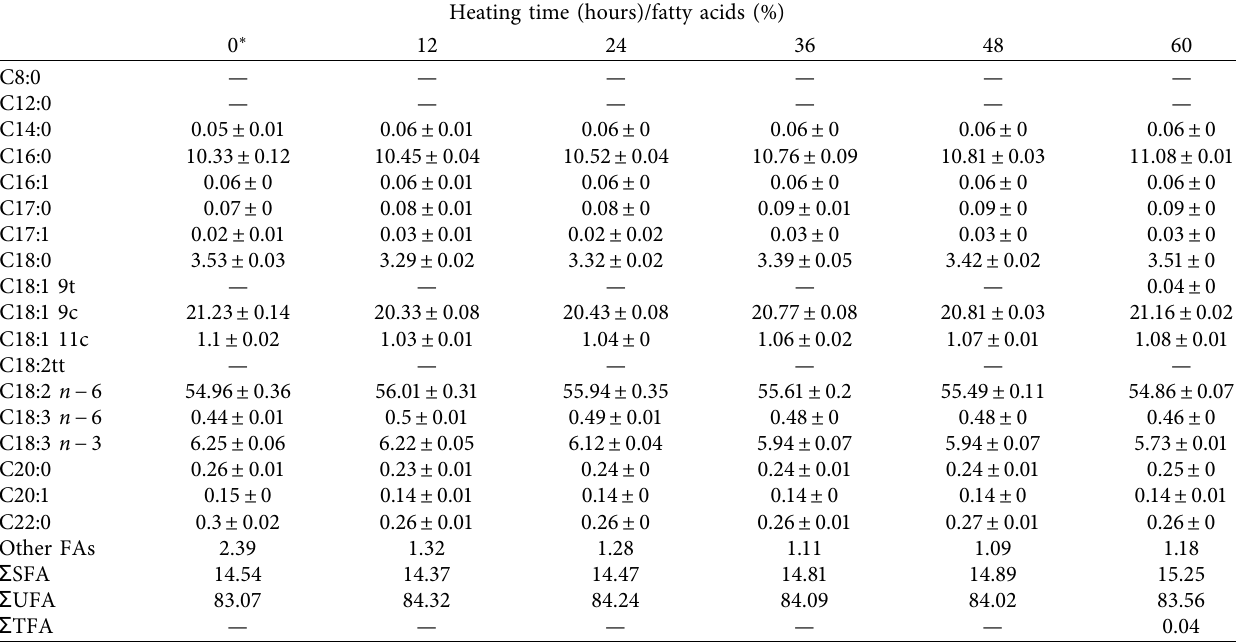
Table 1: Variation of fatty acids of soybean oil under 150 ° C heating temperature at different heating times. Heating time (hours)/fatty acids (%)